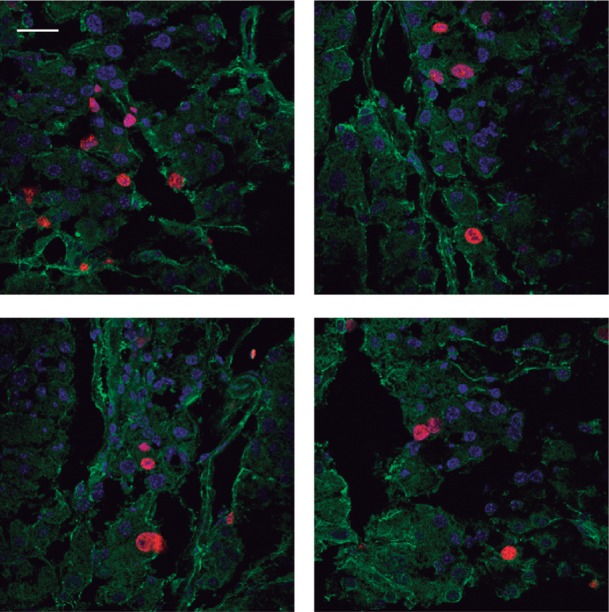
Ki67 is expressed in pancreatic epithelial cellsRepresentative immunofluorescence stainings of pancreatic tissue of 20-week-old R26AID+/KIp48CRE+/KI mice: blue, DAPI; red, Ki67; green, CK8. Scale bar: 50 μm